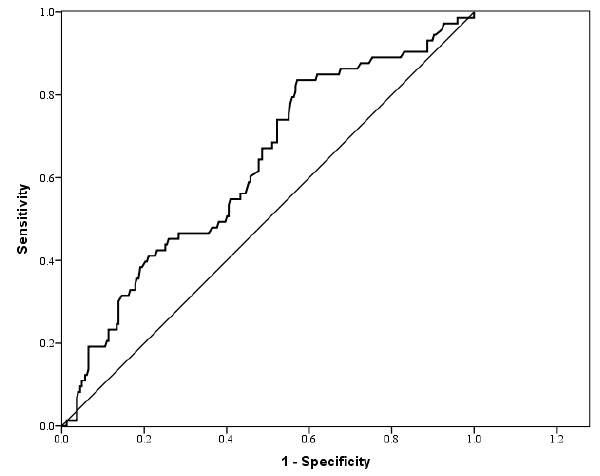
Figure 3. ROC curve for the HOMA-IR index as a predictor of the Framingham risk score.